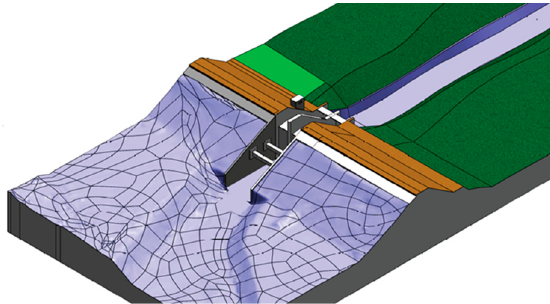
Figure 4. The spillway with reservoir topography and discharge channel.